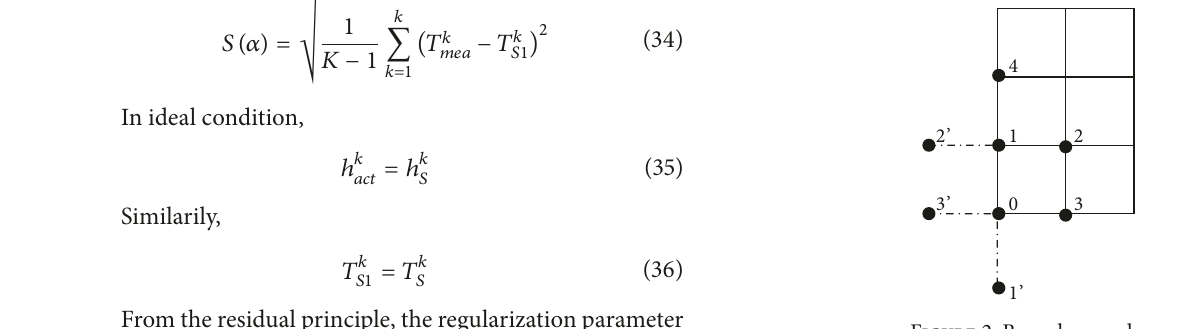
Figure 2: Boundary node.